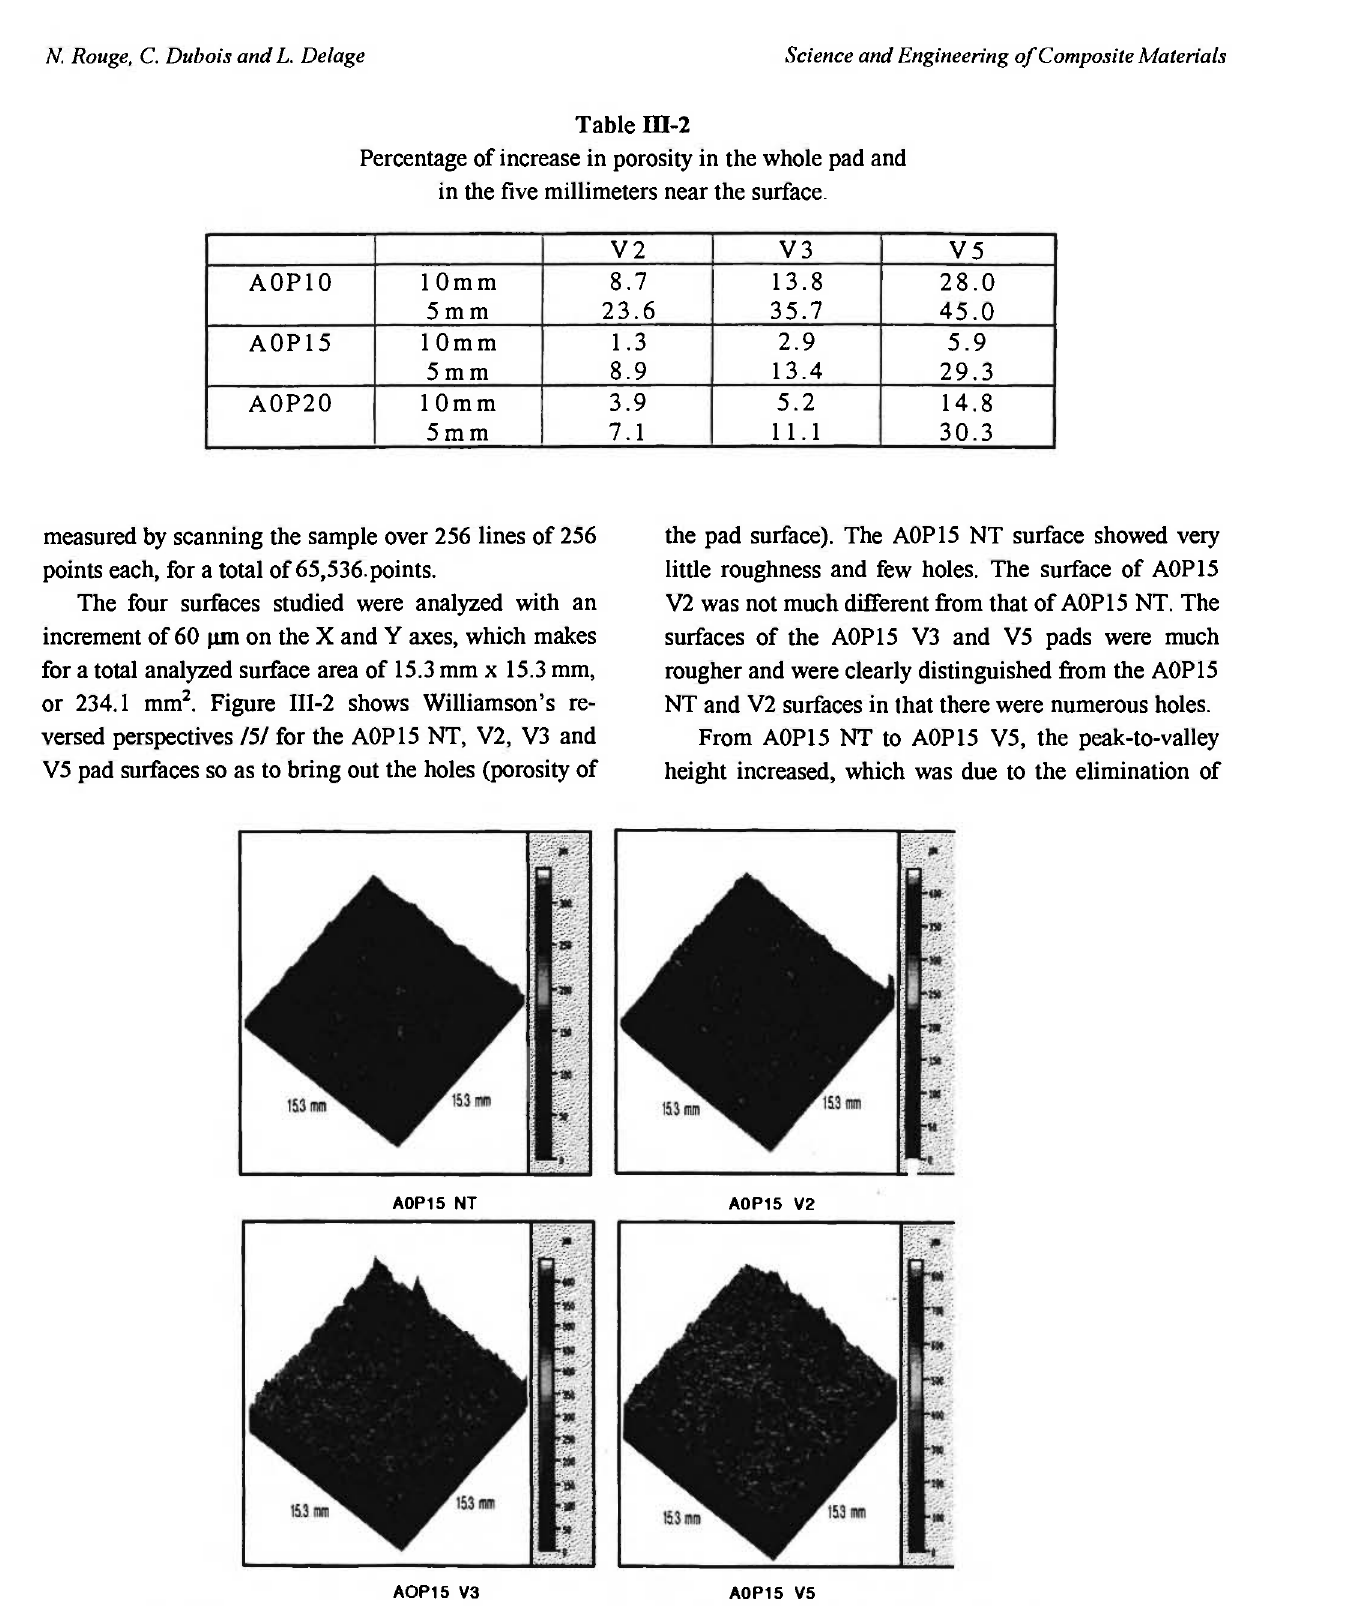
Fig. ΙΠ-2: Williamson's reversed perspectives for the A0P15 NT, V2, V3 and V5 pad